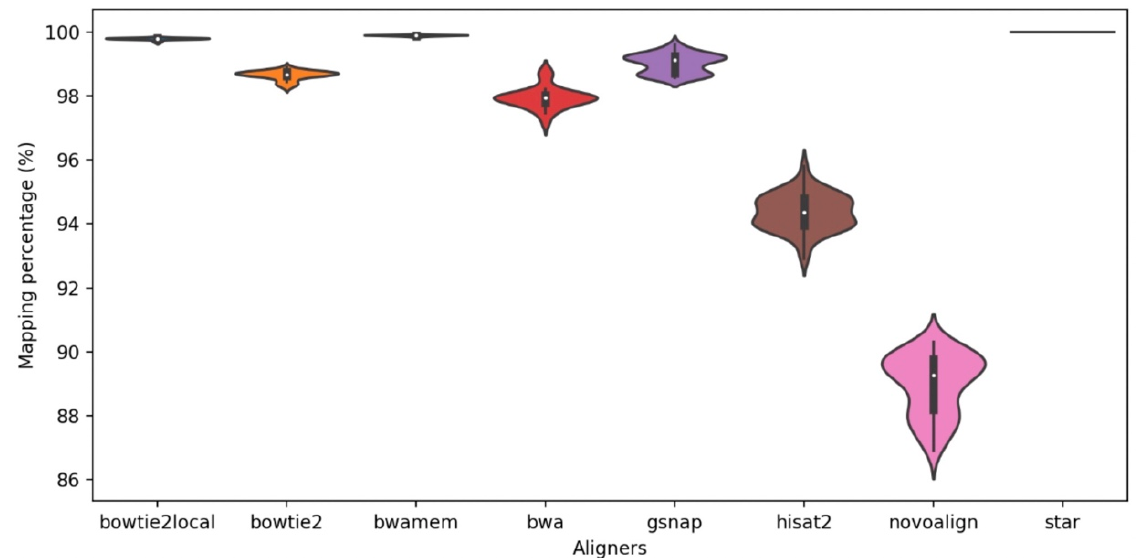
Figure 2. Mapping percentage of the eight aligners; Bowtie2-local (bowtie2local), Bowtie2, BWA-mem (bwamem), BWA- backtrack (bwa), GSNAP, Hisat2, Novoalign, and STAR. Table 1. Average run time of aligners per exome